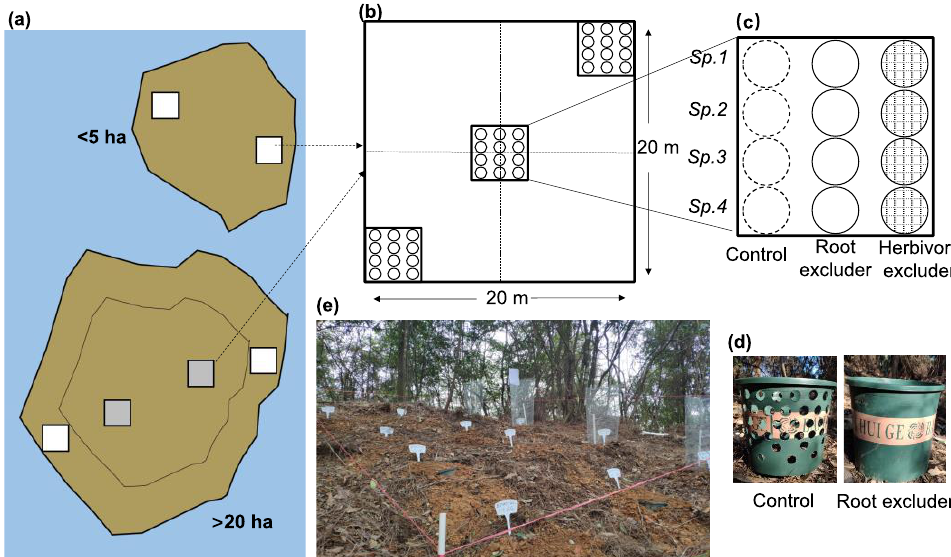
Figure 2. The experiment was conducted on small islands (<5 ha) and large islands (>20 ha) in the TIL ( a ). The experiment contained two edge plots (<40 m to island edge) on all islands and an ad- ditional two interior plots (>40 m) on large islands ( a ). Each plot contained three subplots ( b ) with 12 flowerpots that manipulated belowground competition (dotted line signifies perforated flower- pots to permit other plant roots to grow in; solid line signifies root-excluding flowerpots to pre- vent root competition) and aboveground herbivory (including seed predation) (circle mesh signi- fies a fence over the flowerpots to exclude seed predation and seedling herbivory) for four species ( c ). Root-excluding flowerpots were 21 cm high × 23 cm wide, and all flowerpots were open on the bottom ( d ). A photograph of a subplot in the experiment appears in ( e